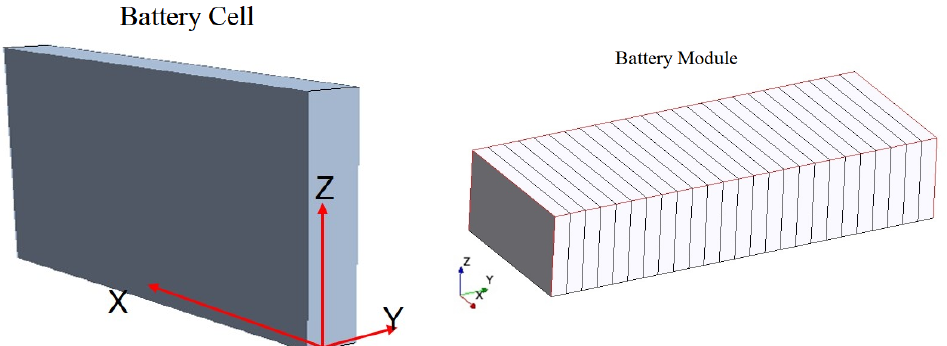
Figure 1. Three-dimensional model of the battery cell and the